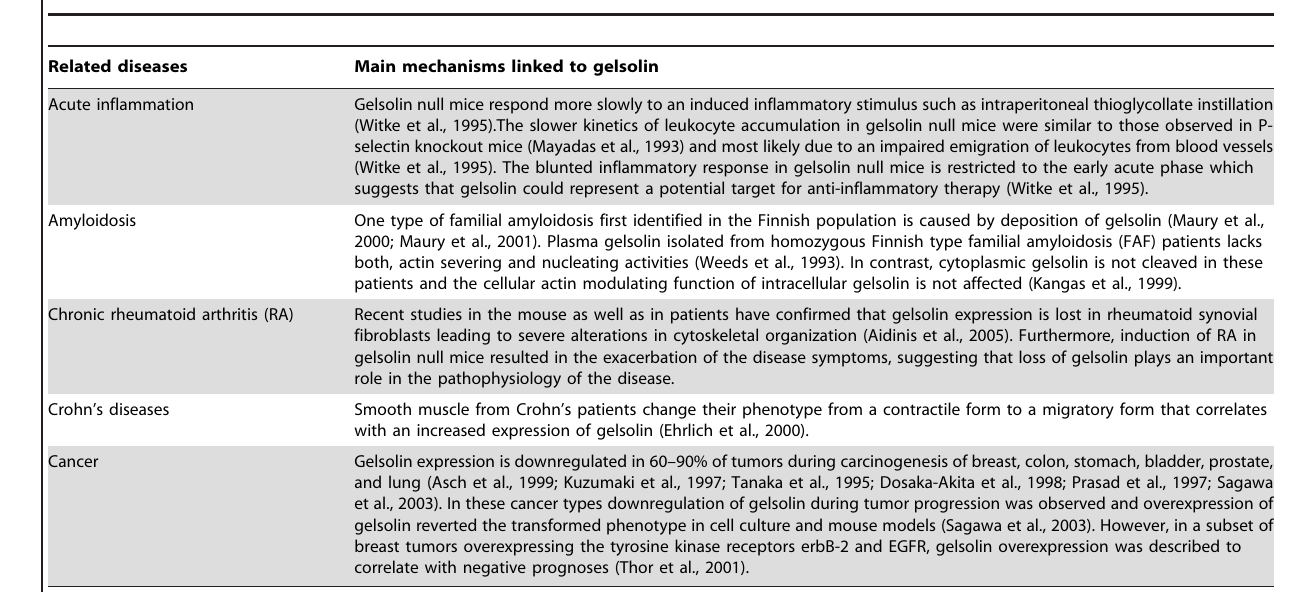
Table 1. Gelsolin and